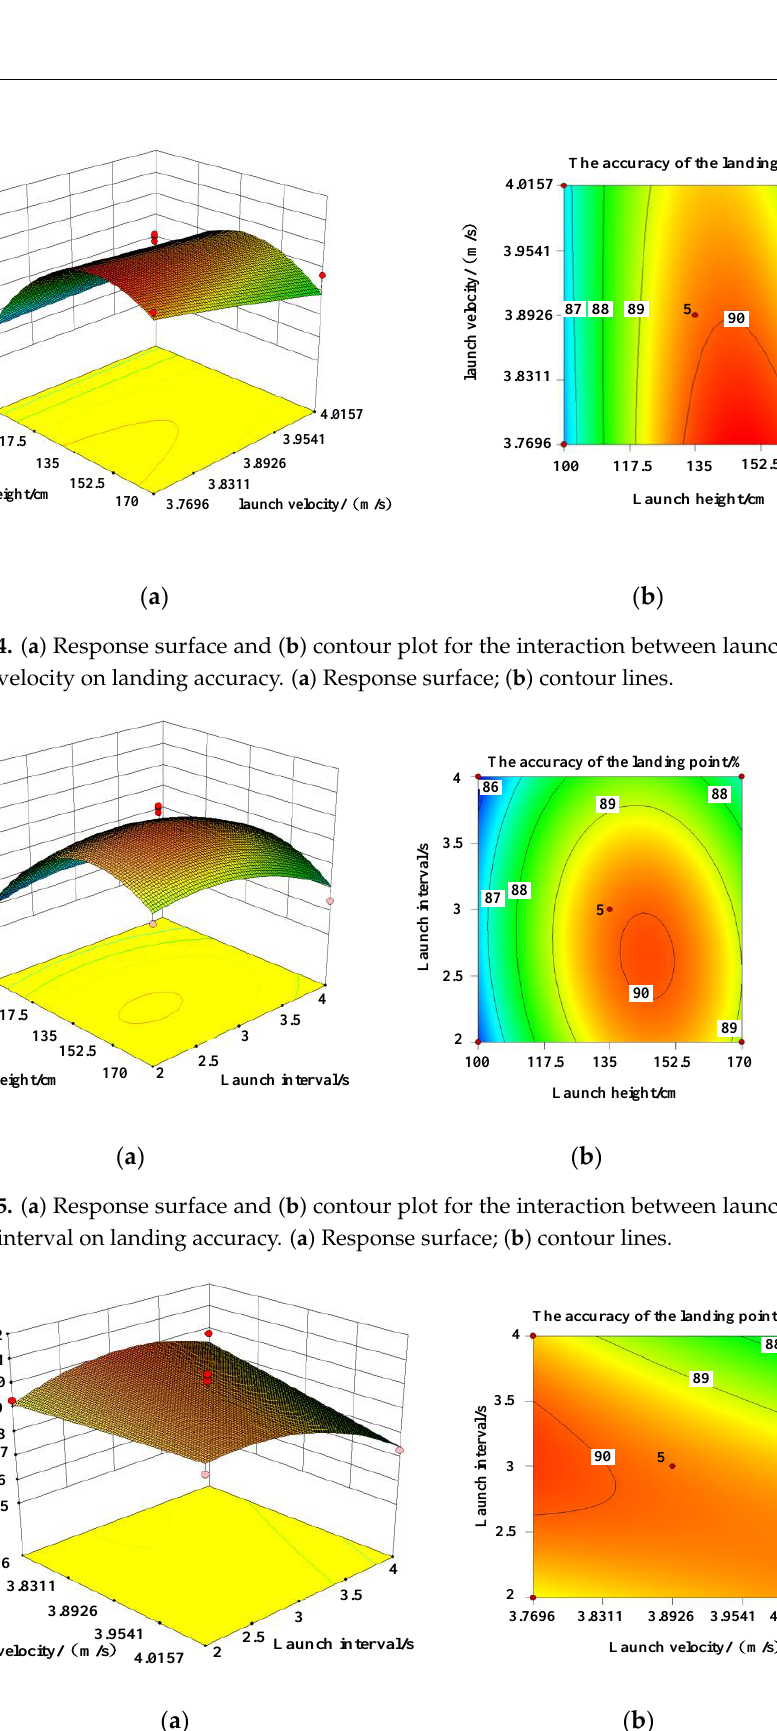
Figure 6. ( a ) Response surface and ( b ) contour plot for the interaction between launch velocity and launch interval on landing accuracy. ( a ) Response surface; ( b ) contour lines.